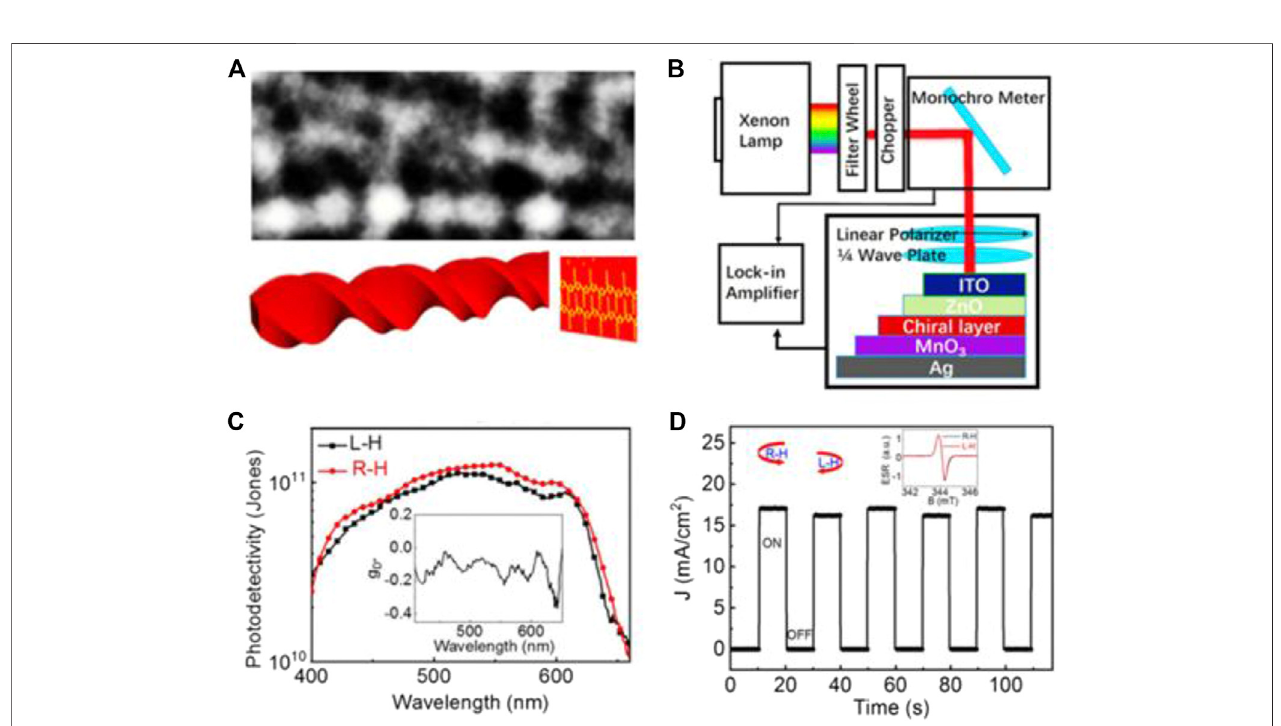
FIGURE 10 | (A) TEM and scheme of the chiral PT nanowire structure, (B) schematic diagram of the setup used for CPL detection, (C) wavelength-dependent detectivity ( D* ) of the chiral PT – based photodetectors, and (D) photocurrent of ITO/ZnO/chiral PT:PCBM/MoO 3 /Ag under the stimuli of left-handed and right-handed CPL illumination (Wang et al., 2020). Reproduced with permission. Copyright 2020, American Institute of Physics.